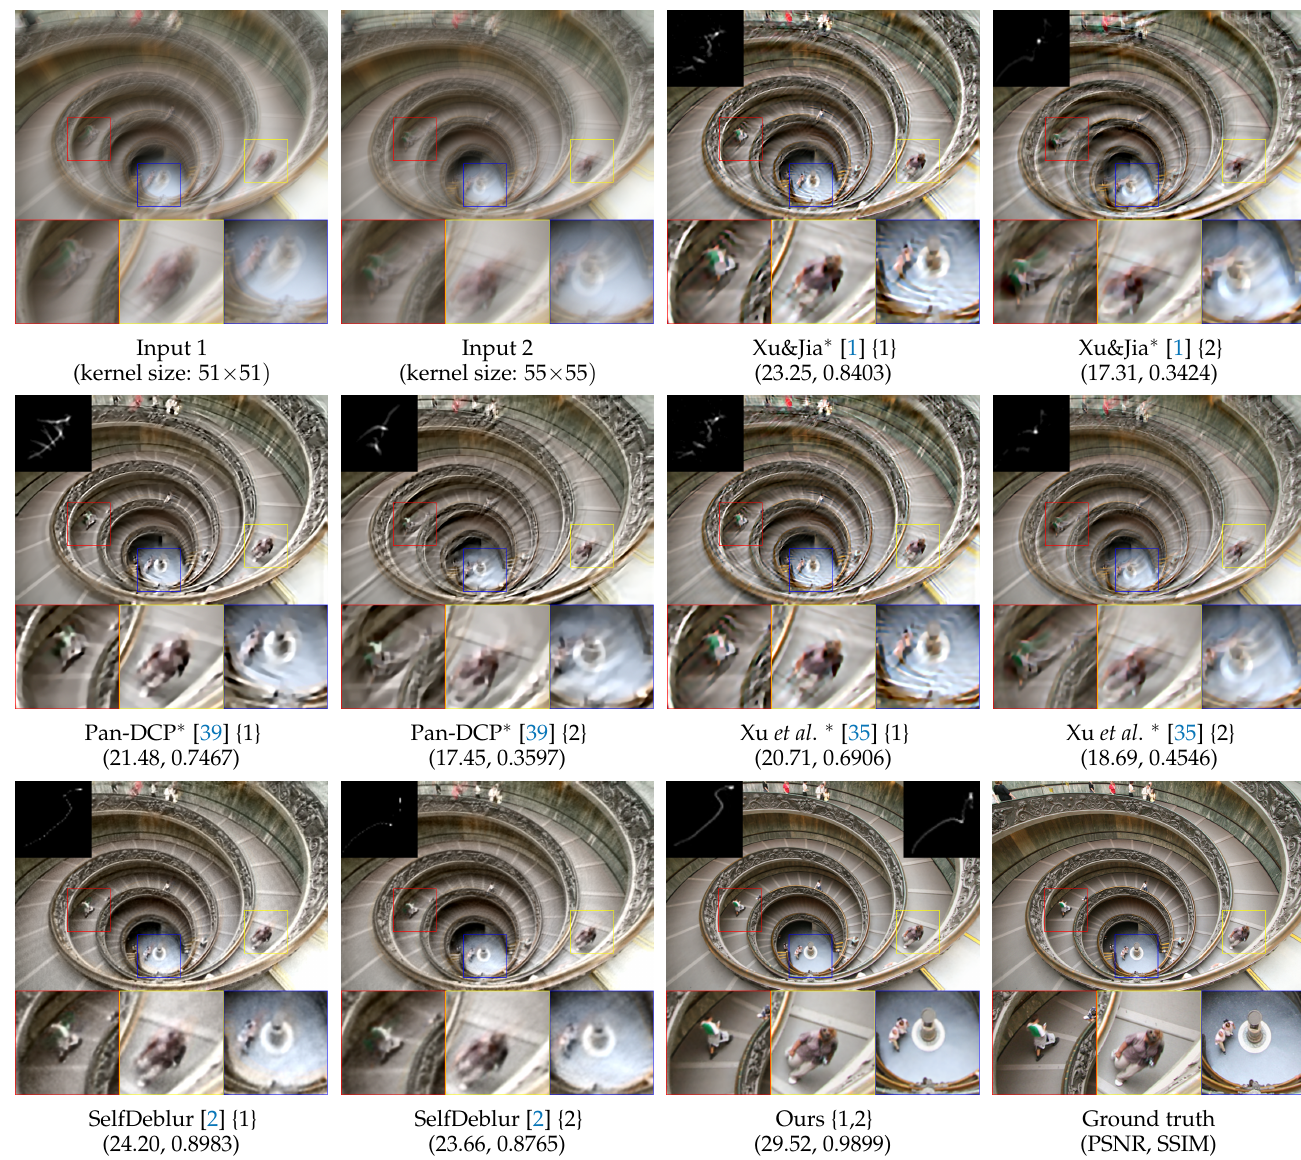
(i.e., ours {1,2} indicates our {}